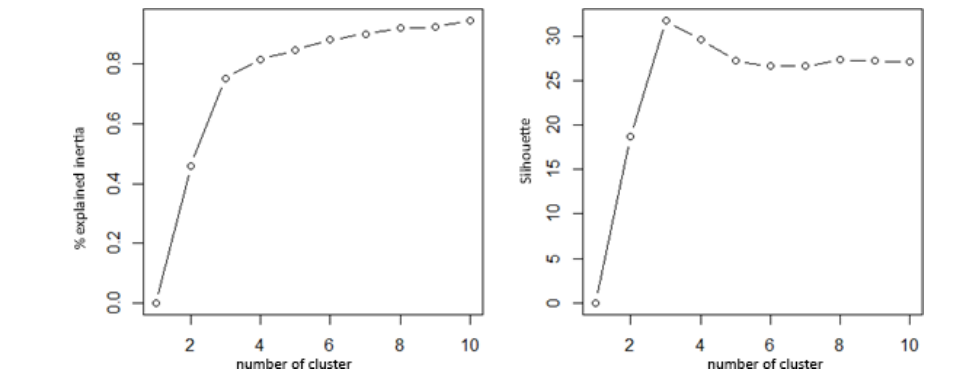
Figure 7. Silhouette values to define the optimal number of clusters.